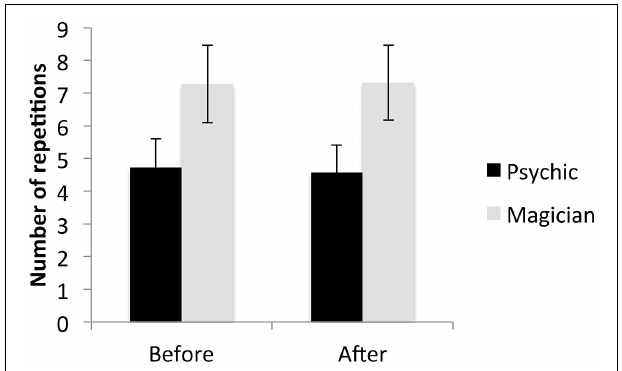
FIGURE 2 | Mean number of repetitions in the mental dice task before and after the demonstration of the anomalous event as a function of the contextual framing condition (error bars denote standard